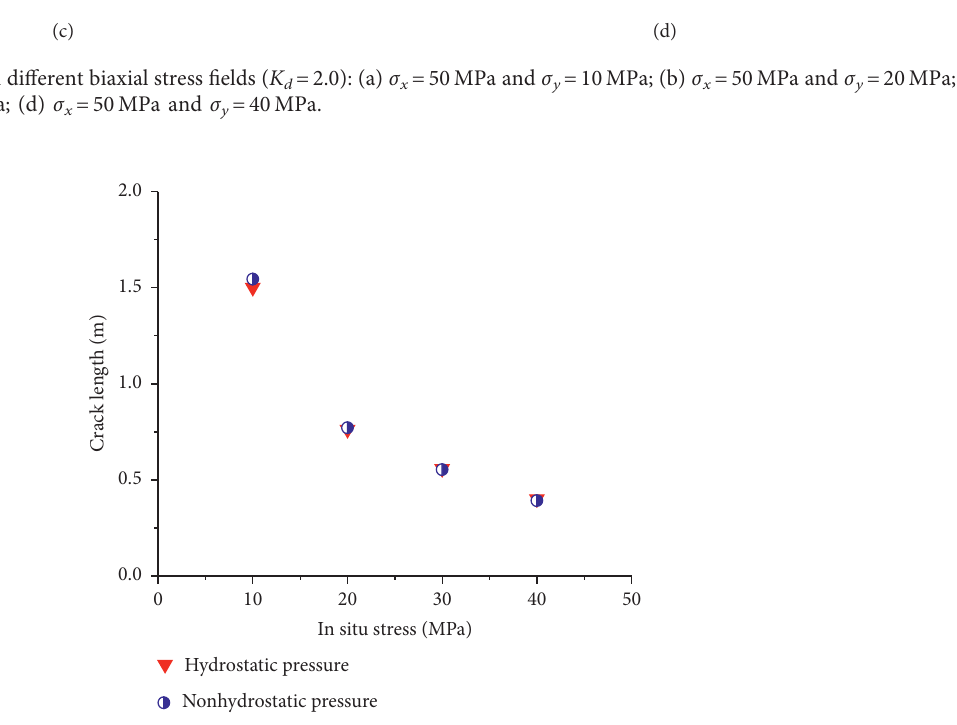
� 50MPa) in the X - x